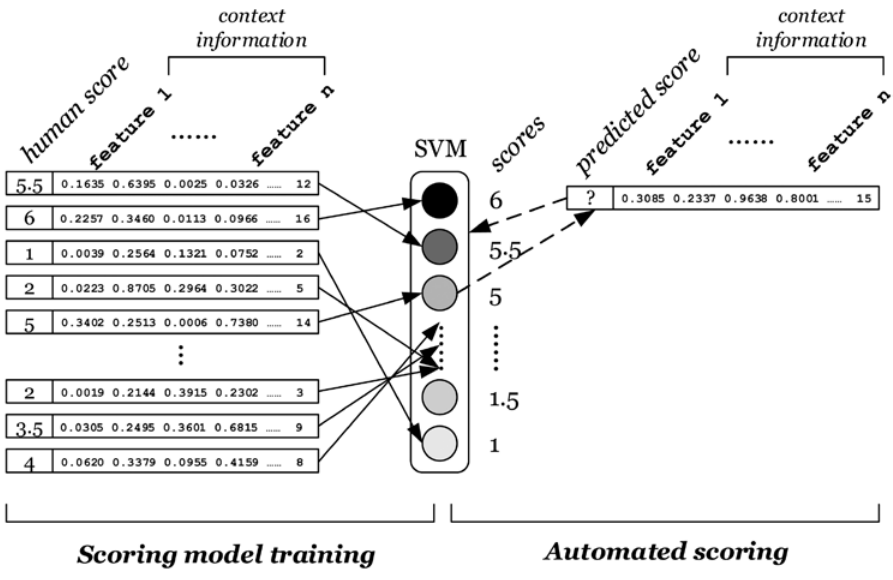
Figure 12: The SVM-Based Scoring